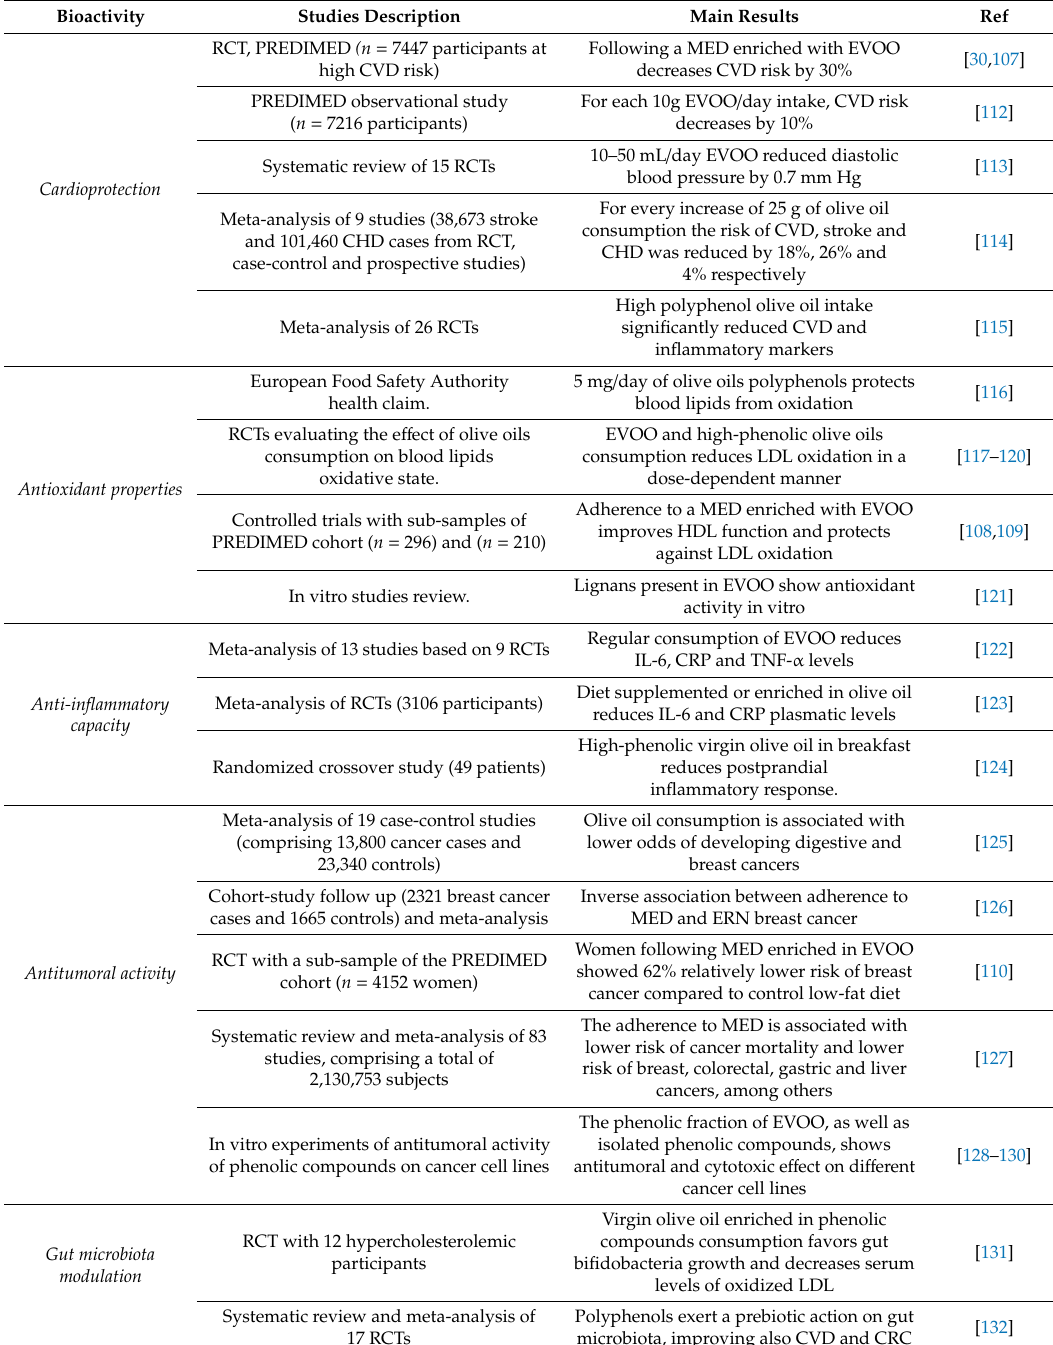
Table 3. Main bioactivities associated with EVOO